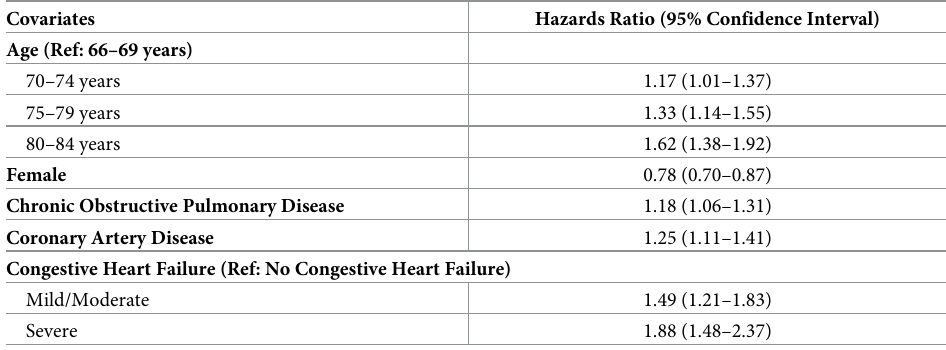
Table 2. Adjusted risk factors for death from non-lung cancer causes for patients with locoregional NSCLC treated with lobectomy and no adjuvant chemotherapy (n = 7,852).